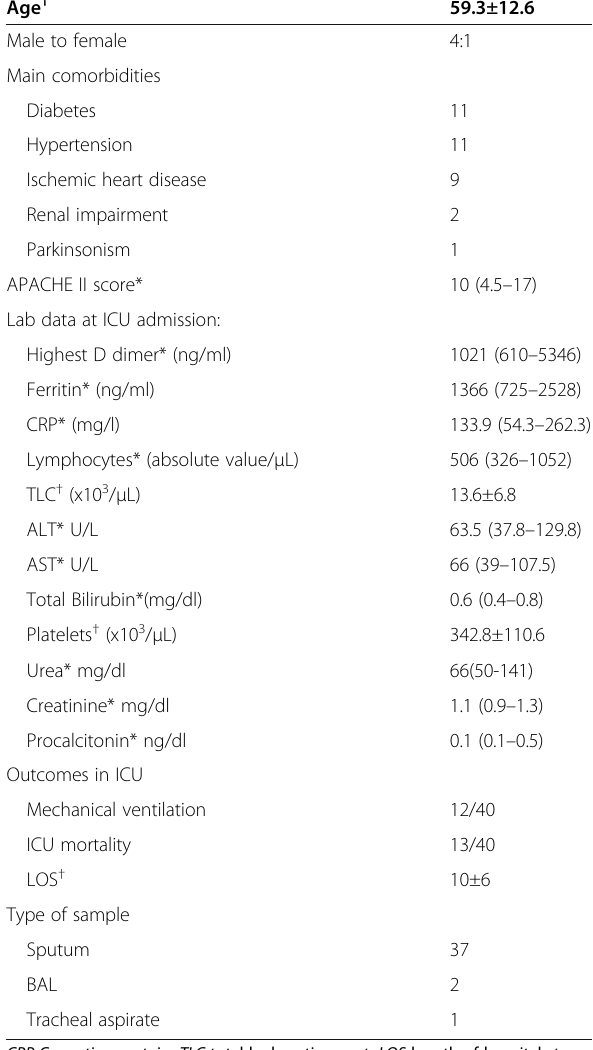
CRP C-reactive protein, TLC total leukocytic count, LOS length of hospital stay, BAL bronchoalveolar lavage. *Data are represented by median and interquartile range. † Data are represented by mean and standard